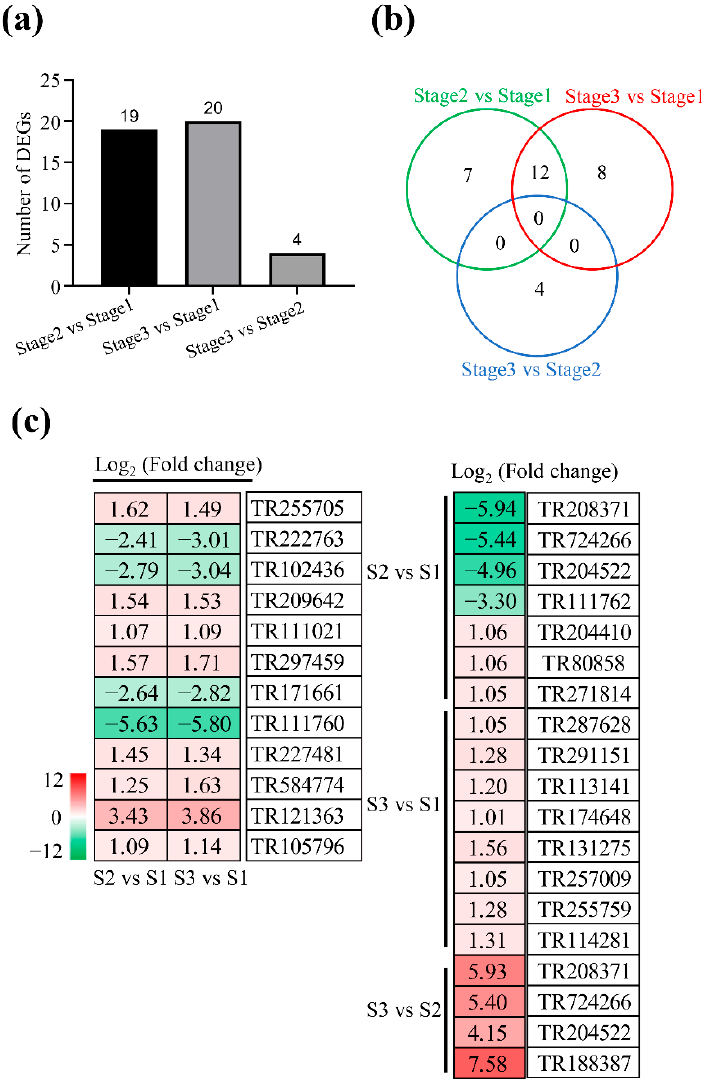
Figure 6. Analysis of differentially expressed genes involved in signal transduction. ( a , b ) Summary of differentially expressed genes at stage 1, stage 2, and stage 3. ( c ) The list of differentially expressed genes. Red and green represent up-regulated and down-regulated, respectively.